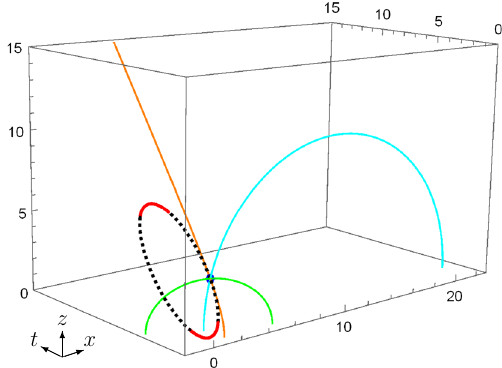
Fig. 9 We see here the same tilted oval (85) as in Fig. 8, from a greater distance and a different perspective. The point λ = 4 π/ 5 in the nonre- constructible region is marked, and the geodesic tangent to the oval at that point is shown in orange. One of its endpoints exits the Poincaré wedge through the horizon, z → ∞ , so it cannot be associated with entanglement entropy in the CFT. Nonetheless, null vector alignment u → U = u + n allows us to reorient this geodesic so that both of its endpoints land on the boundary of Poincaré AdS, z = 0. Among the infinitely many different ways in which this can be done, we illus- trate the two examples described in the main text: the green geodesic has U z = 0, and the cyan geodesic has U t = 0. With either of these choices, we are able to translate the given point into CFT